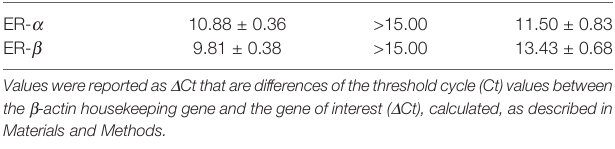
TABLE 1 | ER gene expression in ACC cell lines and primary cell culture. Target